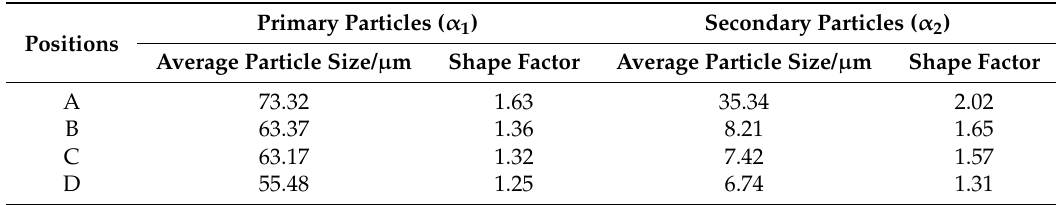
Table 2. Average particle size and shape factor of α 1 and α 2 in different positions of diecasting.